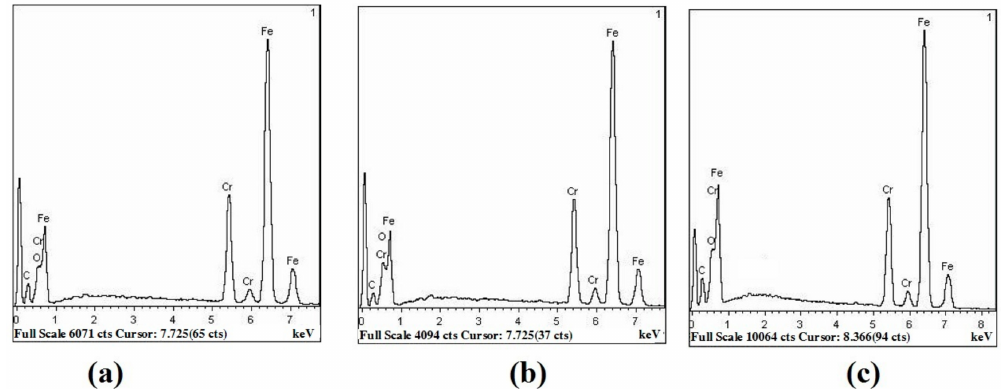
Figure 8. EDS Energy Spectrum of: ( a ) as-deposited, thermal shock test for ( b ) 203.2 h, ( c ) 812.8